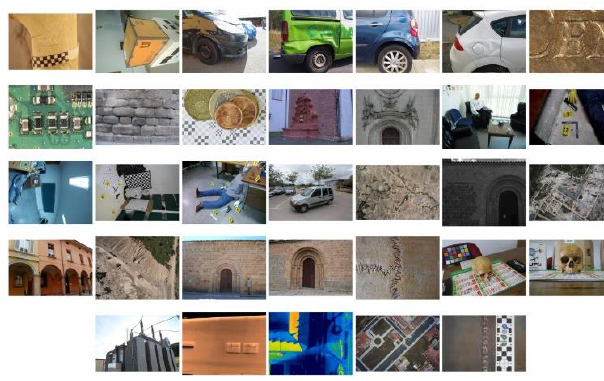
Figure 1. Some of the images of the database used in the testing phase.